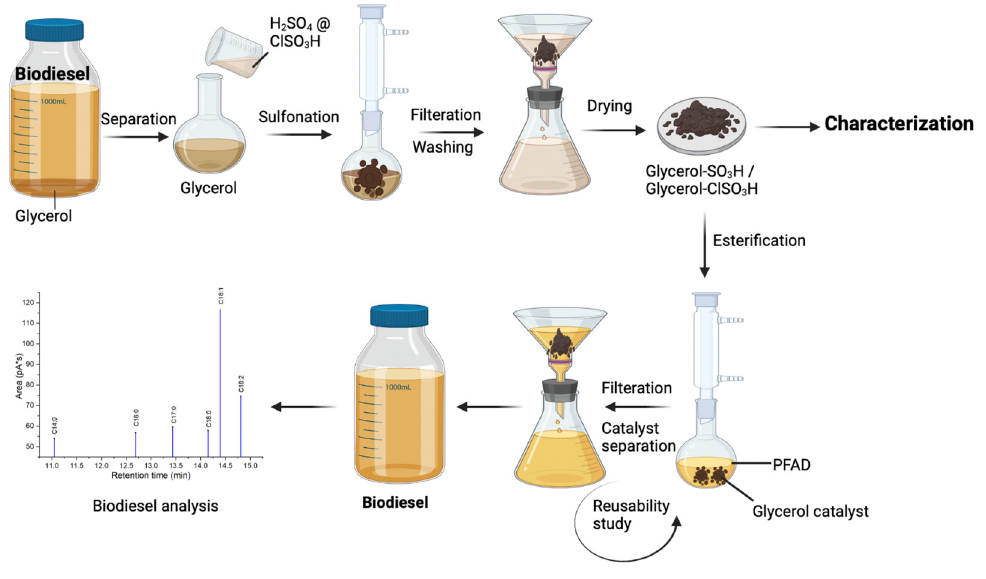
Figure 10. Process flow of catalyst preparation, esterification reaction and biodiesel analysis.